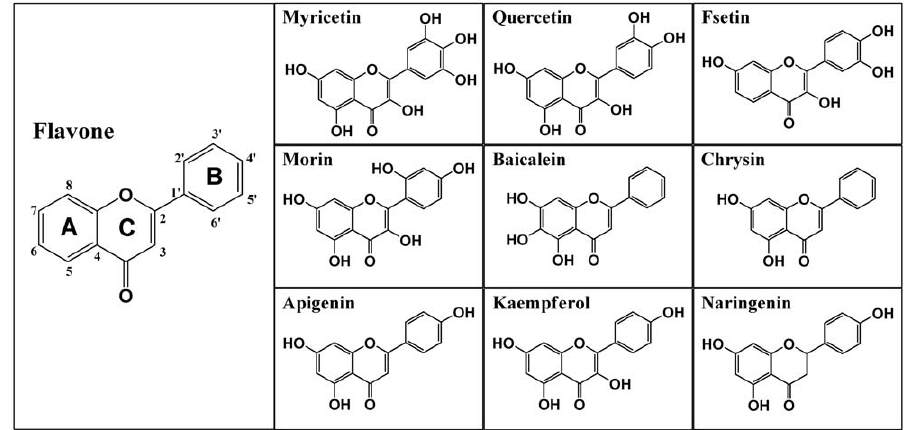
Figure 1. Chemical structures of the bioflavonoids used in this study. The structure of flavone is enlarged to show the numbering of different carbon positions.